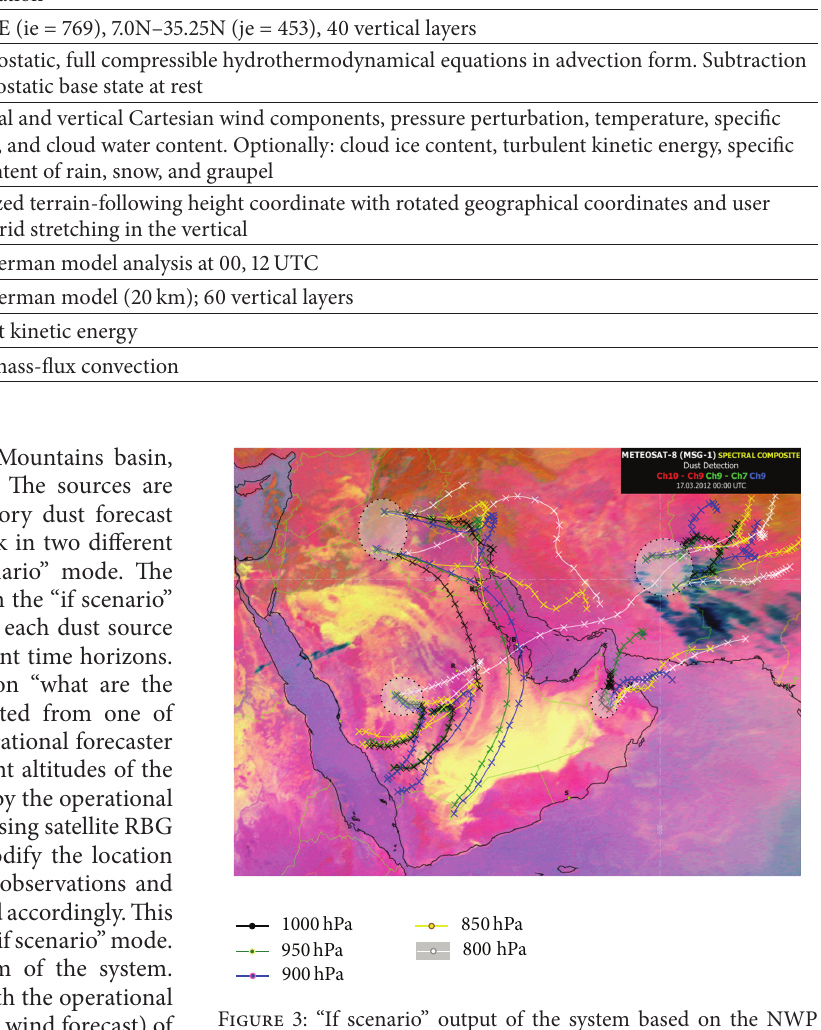
Figure 3: “If scenario” output of the system based on the NWP model run at 17/3/2012 00